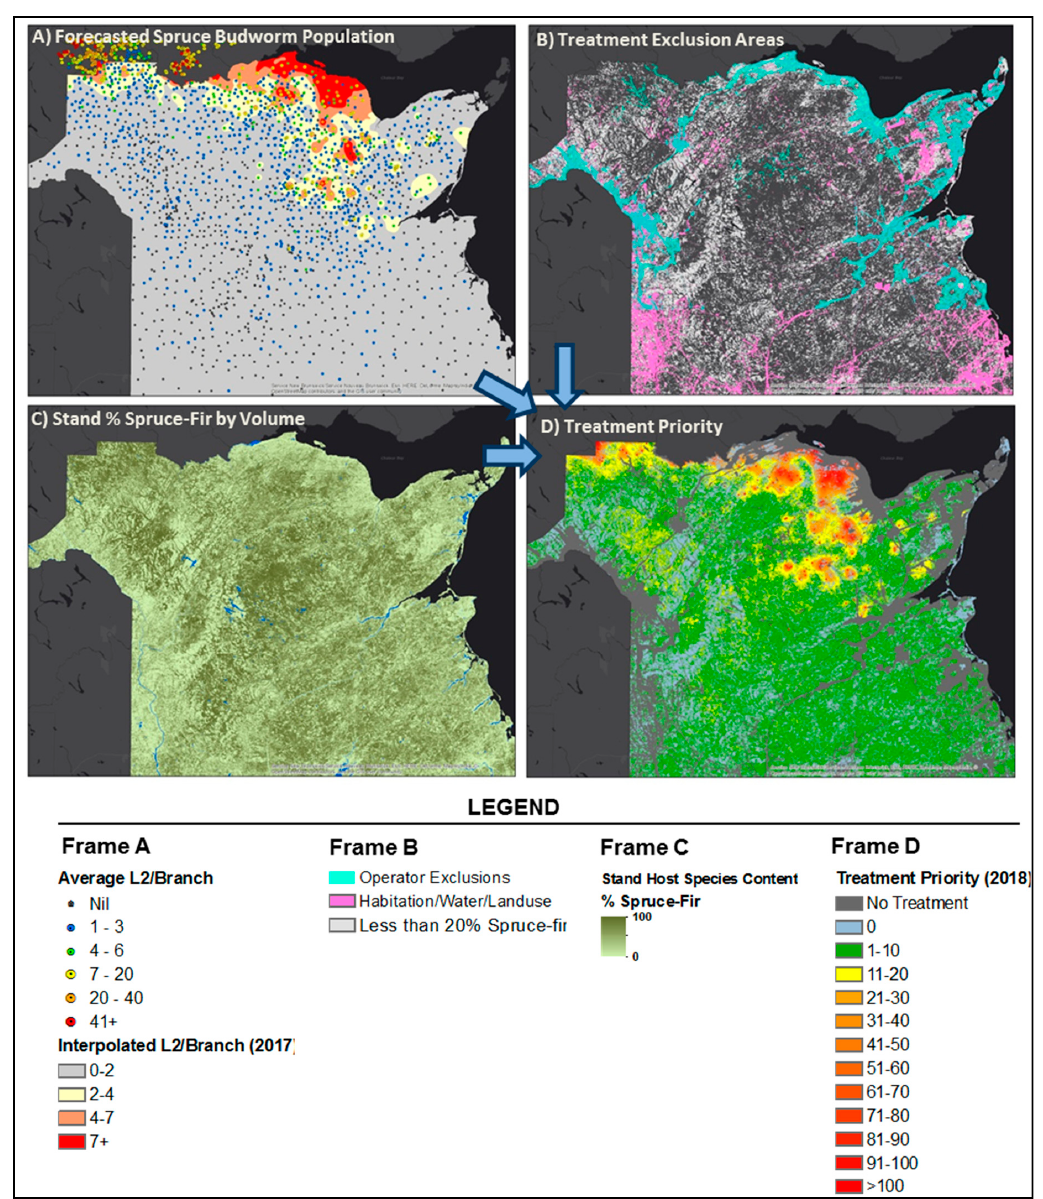
Figure 3. Inputs required for developing the 2018 treatment priority raster map, including: A ) interpolated L2 population, B ) treatment exclusion areas, C ) stand percent spruce-fir, and D ) the final treatment priority map as a function of scaled L2 plus percent spruce-fir content with treatment exclusion areas